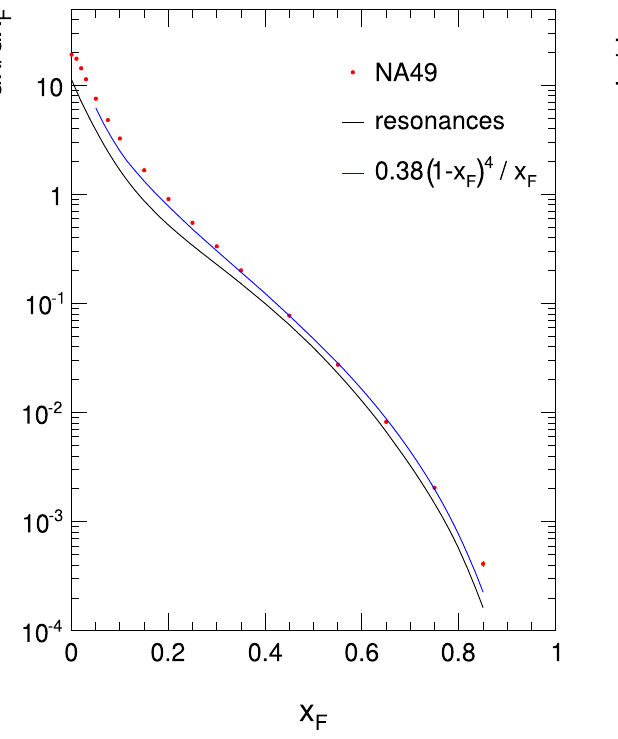
Fig. 196 dn / dx F of π − as a function of x F for the inclusive NA49 data and for the decay of the resonances contained in Table 9. A fit to the data suggesting the down-quark structure function is superimposed